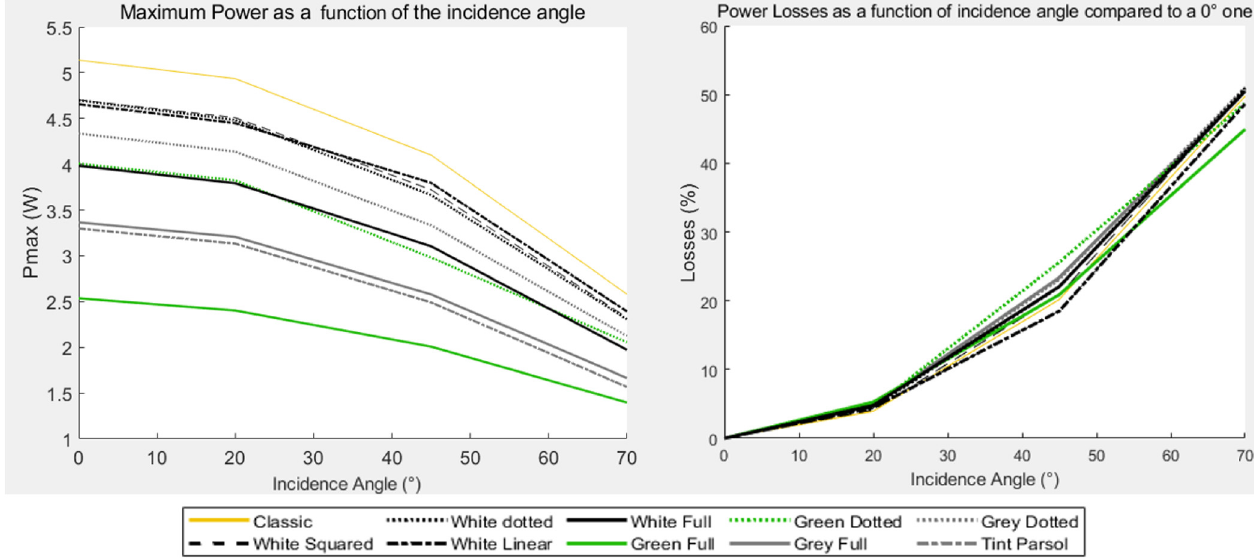
Fig. 7. Measured P max absolute values and P max losses as a function of the angle-of-incidence, at 1000 W/m 2 , for the different color/ pattern coated PV laminates of the